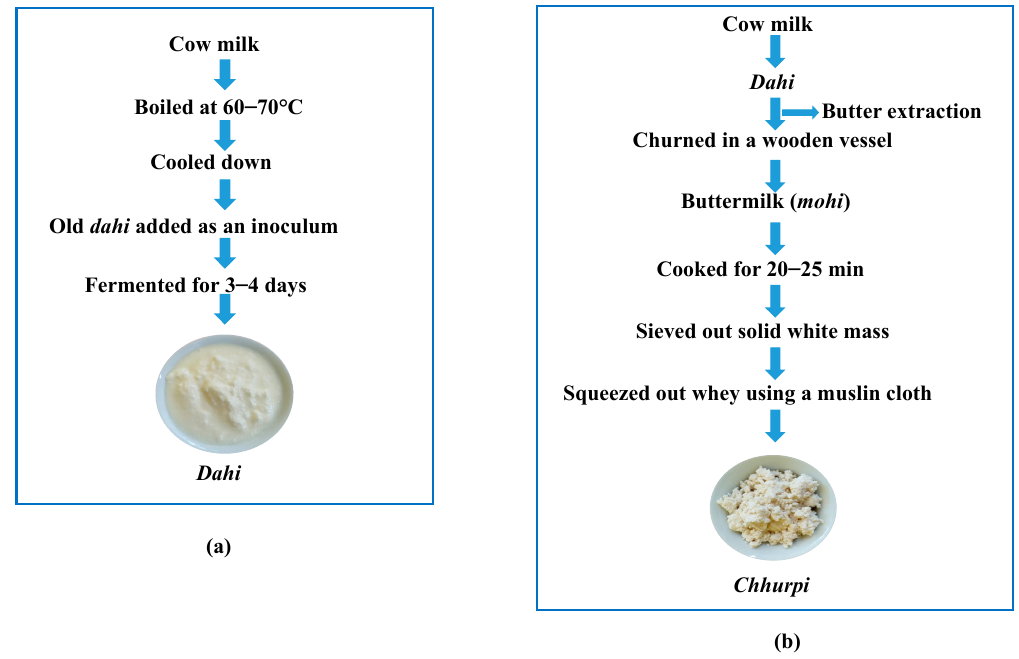
Figure 1. Traditional method of preparation of ( a ) dahi and ( b ) chhurpi in Sikkim.